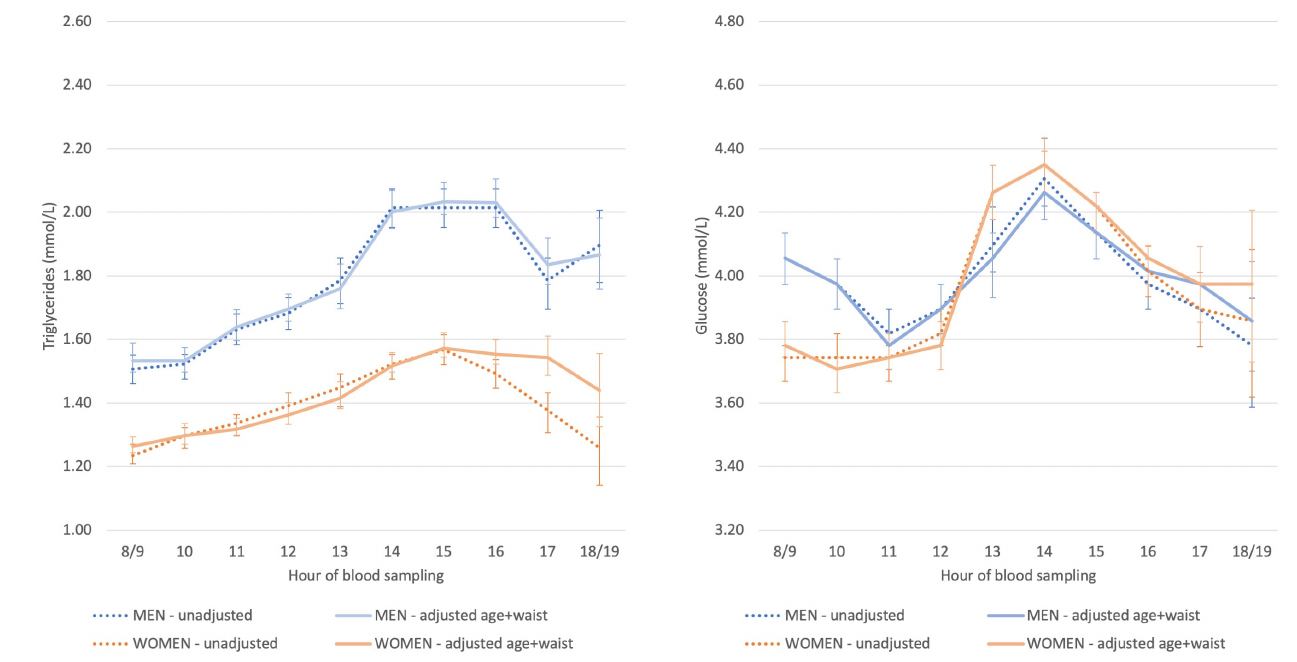
Figure 1. Estimated marginal means (95%CI) of triglyceride and glucose concentrations stratified by sex and adjusted for age and waist circumference (continuous). The axes have been made comparable with the axes in subsequent figures to facilitate comparisons.